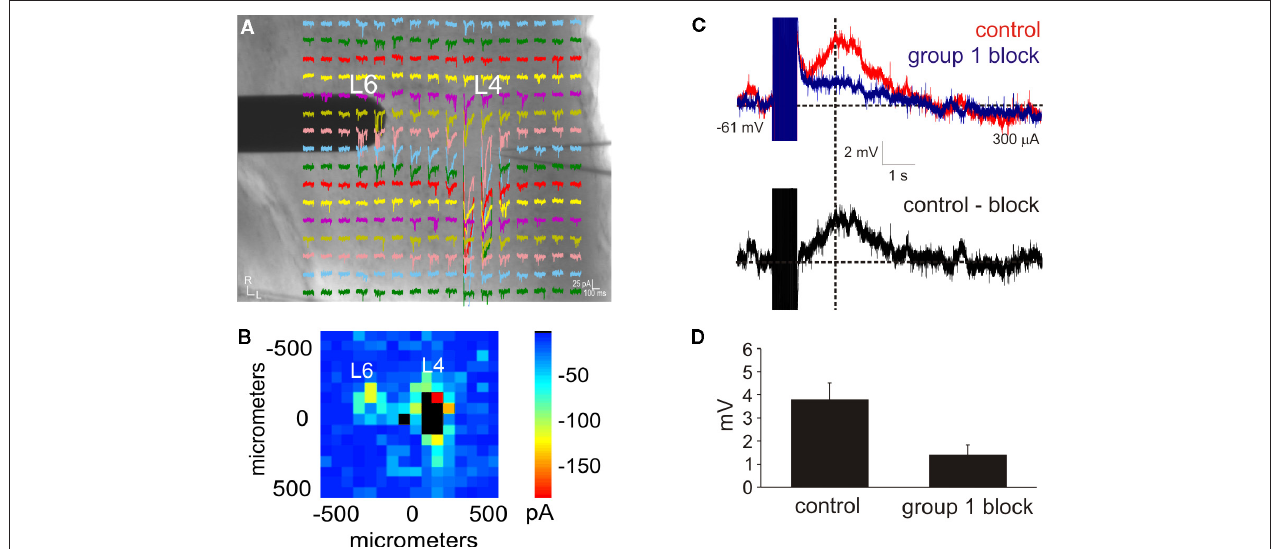
FIGURE 1 | Intracortical projections from layer 6 to layer 4 exhibit a modulator property. (A,B) Photostimulation with caged glutamate in the cortex (AII) identifi es the location of layer 6 input to layer 4. (A) Whole-cell, voltage clamp recordings from layer 4 (L4) in response to photostimulation at 256 separate cortical loci (colored traces). A concentric bipolar electrode was targeted to the region in layer 6 (L6) that elicited the strongest